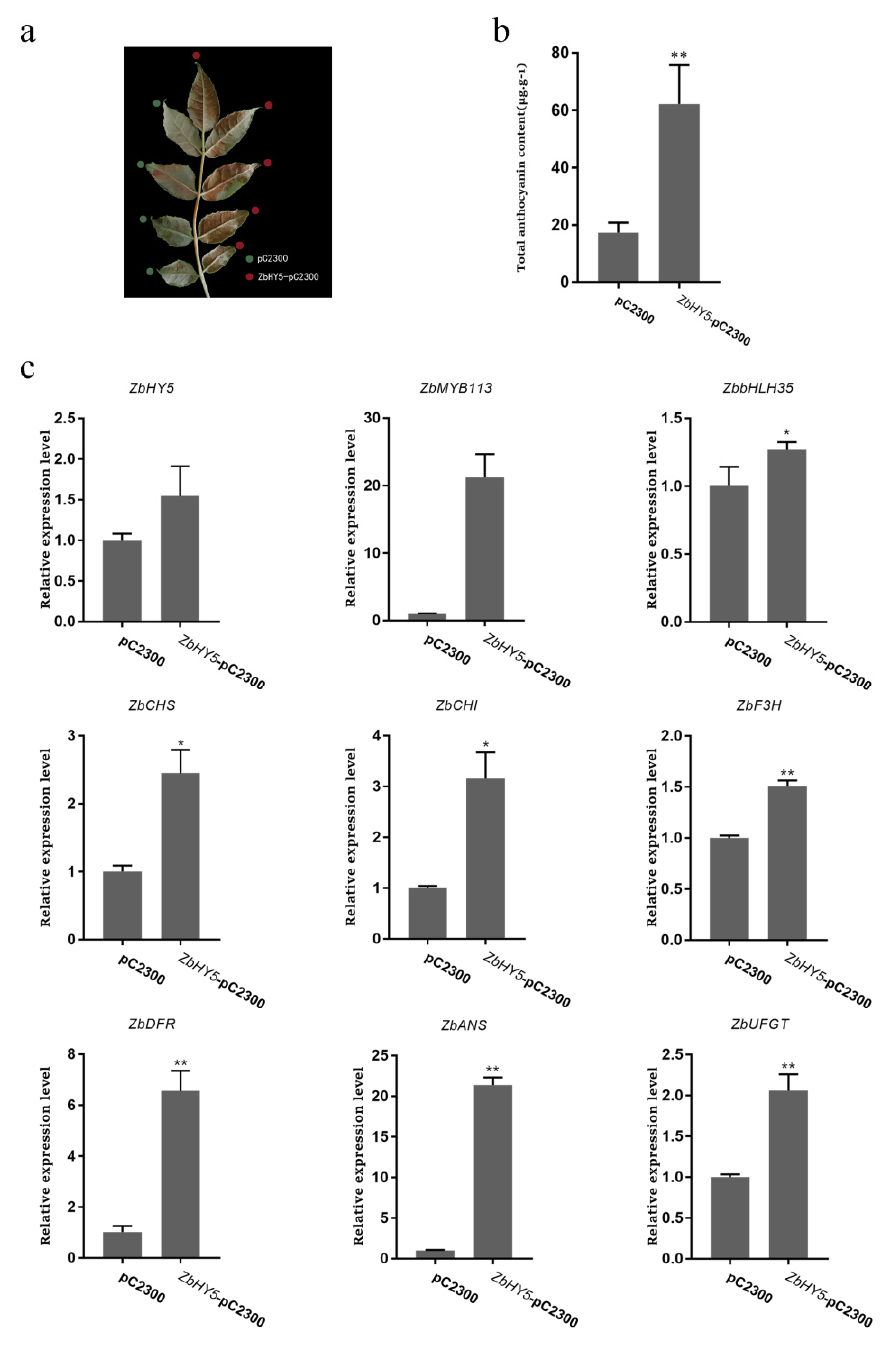
Figure 5. ( a ) Pictures of ZbHY5 gene overexpression phenotype changes in Z. bungeanum leaves. The green marks represent the control (pC2300) leaves, and the red marks represent the experimental group ( ZbHY5 -pC2300) leaves. ( b ) Determination of total anthocyanin content in ZbHY5 gene overexpression in Z. bungeanum leaves. ( c ) Quantitative analysis of genes related to ZbHY5 gene overexpression in the leaves. * p < 0.05, ** p < 0.01 using the t -test.